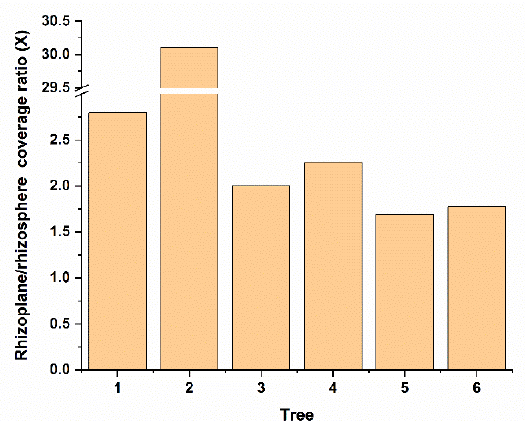
Figure 2. Abundance comparison between rhizosphere and rhizoplane niches of Bin79. The genome coverage ratios between the rhizosphere and rhizoplane niches are calculated by dividing the number of reads mapped from a rhizoplane sample by the number of reads mapped from the corresponding rhizosphere sample.